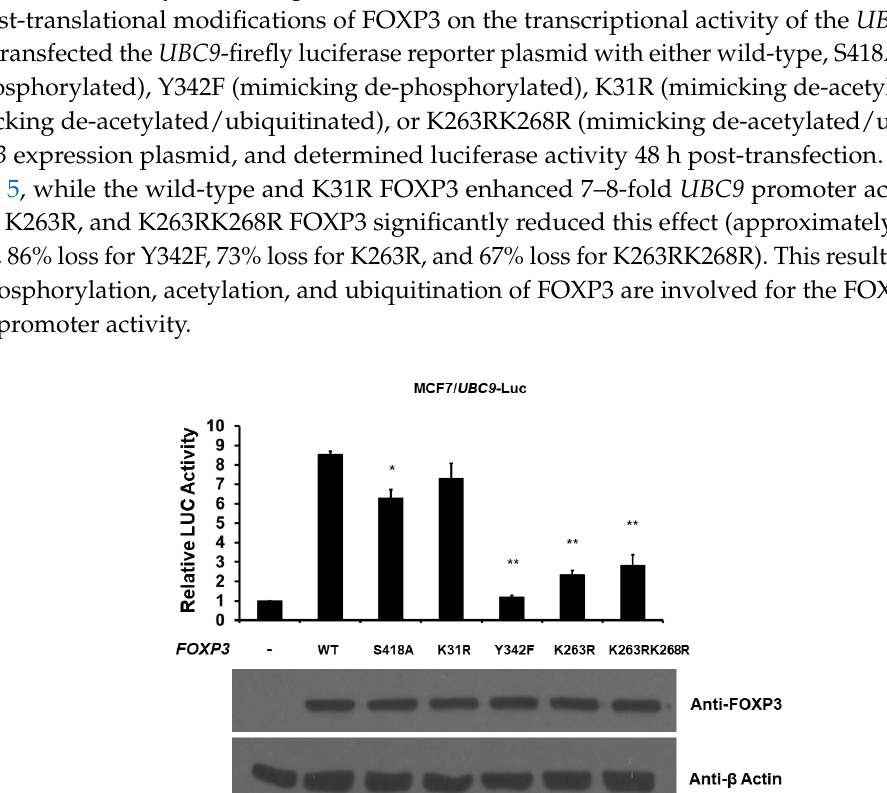
Figure 4. Regions of UBC9 promoter important for transcriptional activation by FOXP3. ( A ) MCF7 cells were co-transfected with UBC9 promoter deletion constructs and FOXP3 expression plasmid. Luciferase activities were measured 48 h after transfection and normalized with Renilla activity. Relative LUC activity (fold activation) was calculated and plotted. The experiments were conducted three times and in triplicate. Error bars indicate the standard error. ** indicates p < 0.001 vs. − 2392 bp construct; ( B ) MCF7 cells were co-transfected FOXP3 plasmid and with either − 2392 wild-type (WT),